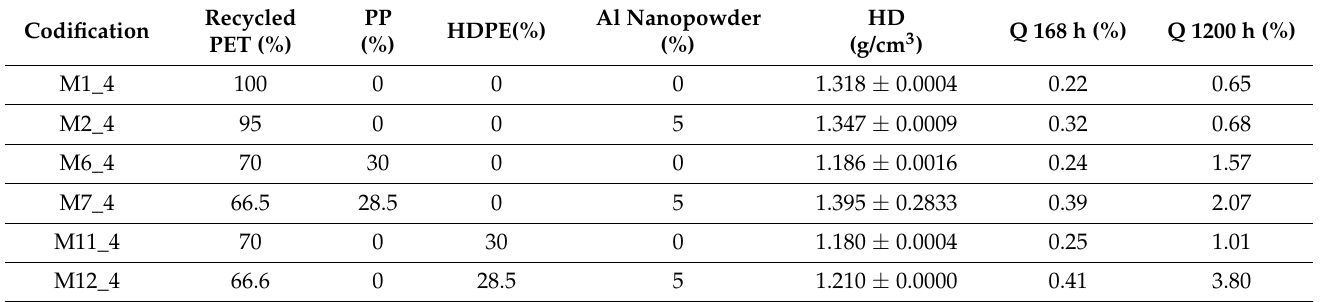
Table 2. Composition, hydrostatic density, and swelling degree of recycled PET